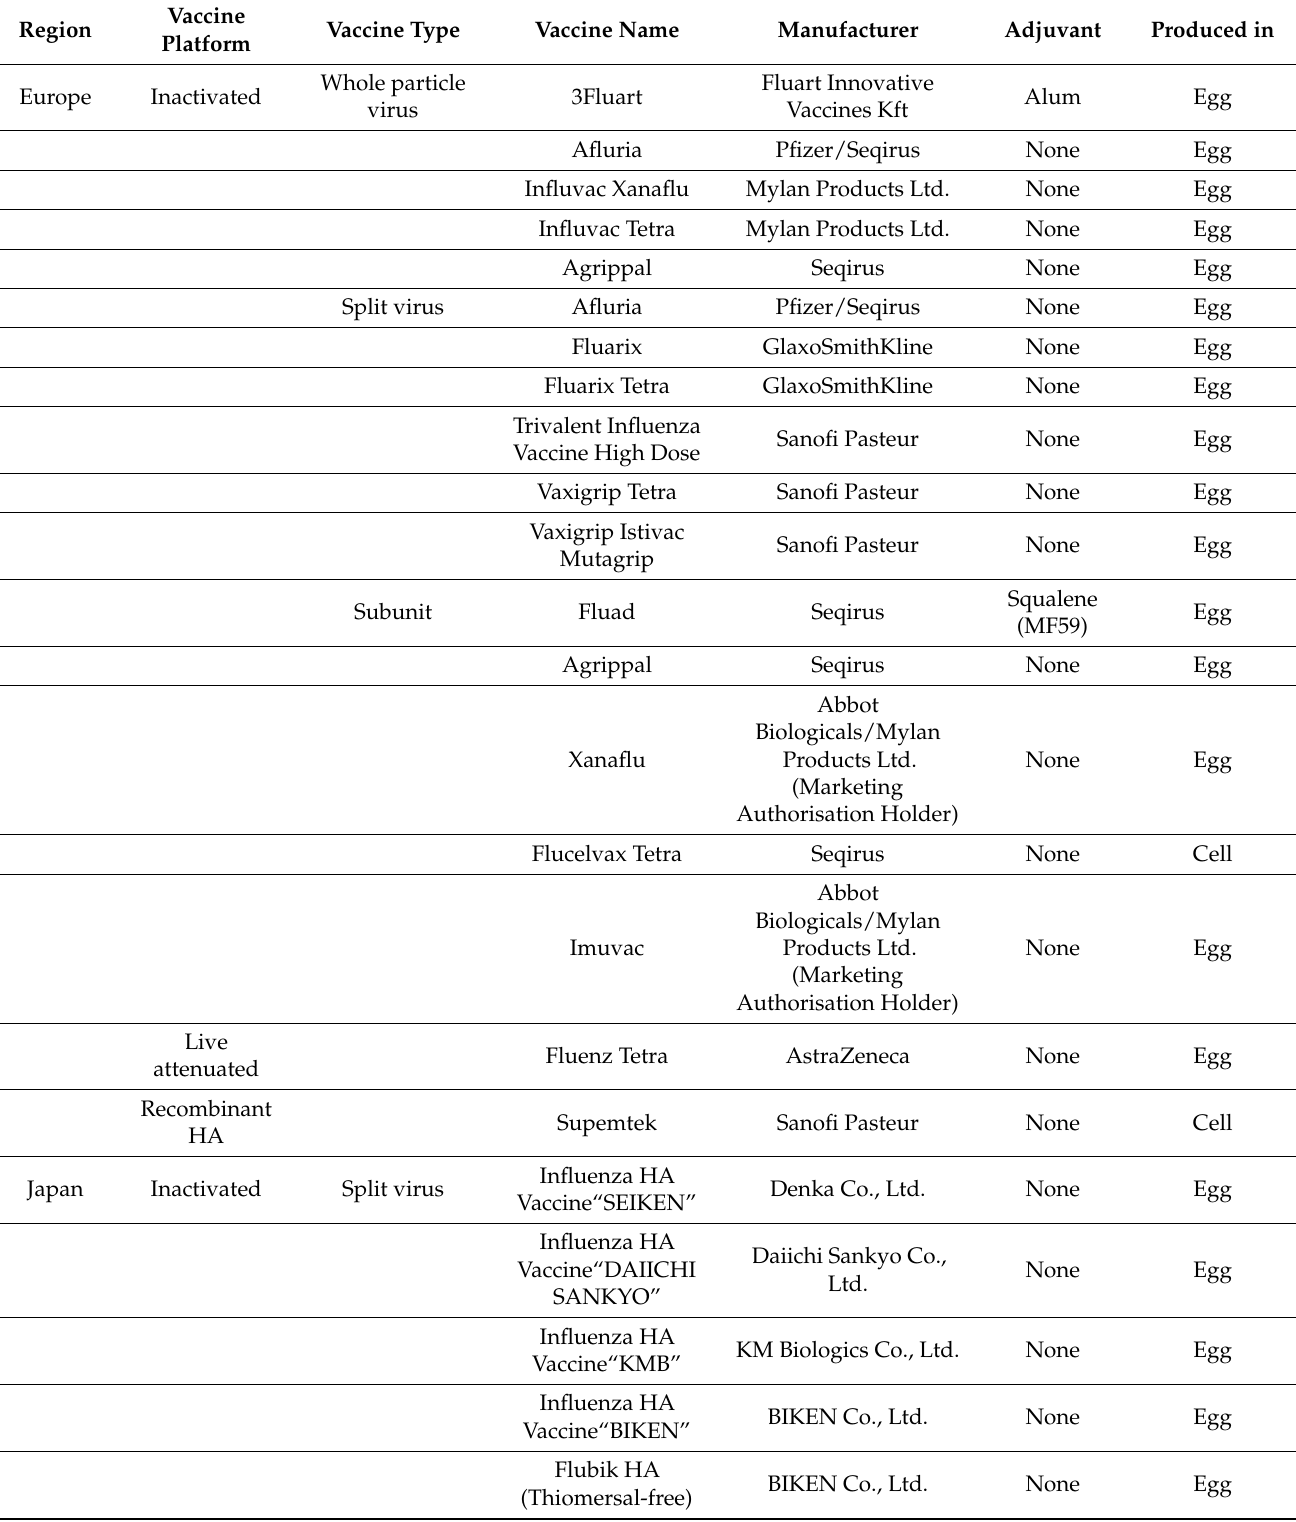
Table 1. Currently licensed influenza vaccines in Europe, Japan and United